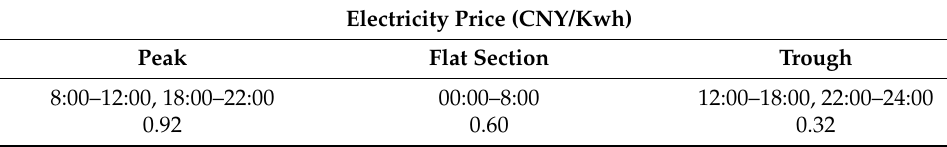
Table A7. Electricity price of Xinxiang City, Henan